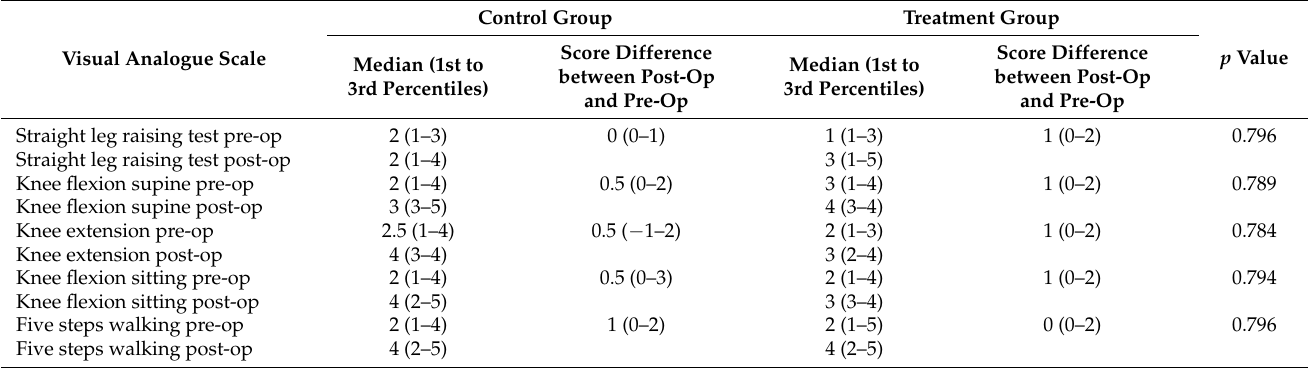
Table 3. Pre-operative (pre-op) and post-operative (post-op) median (first to third percentiles) visual analogue scale during five tasks with their median difference (post-op minus pre-op) for both